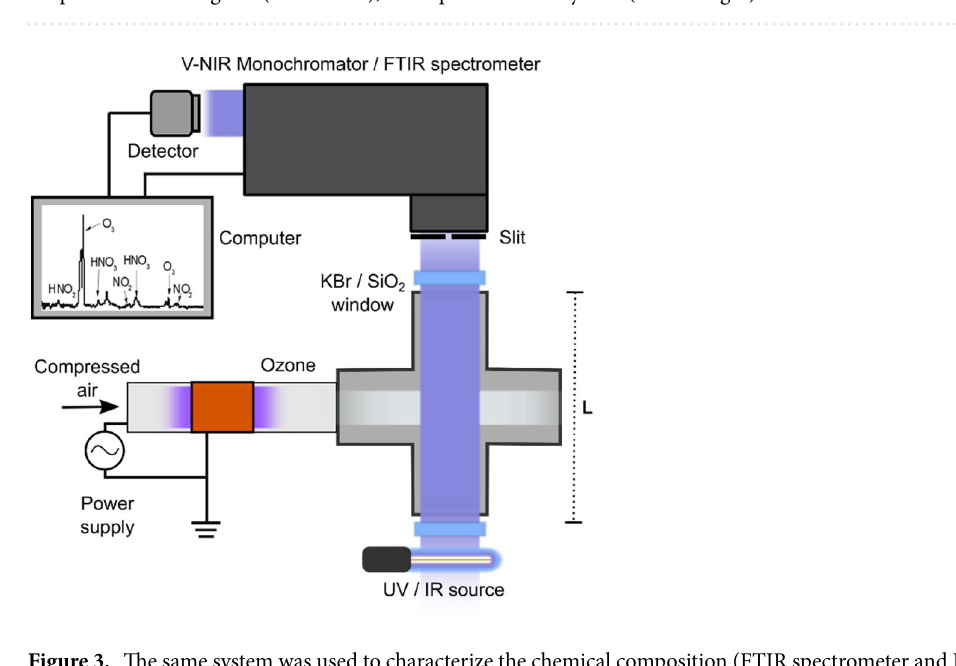
Figure 2. Schematic of cost-effective plasma reactor build by using a commercial toy plasma-ball (top), its simplified circuit diagram (bottom left), and a picture of the system (bottom right).